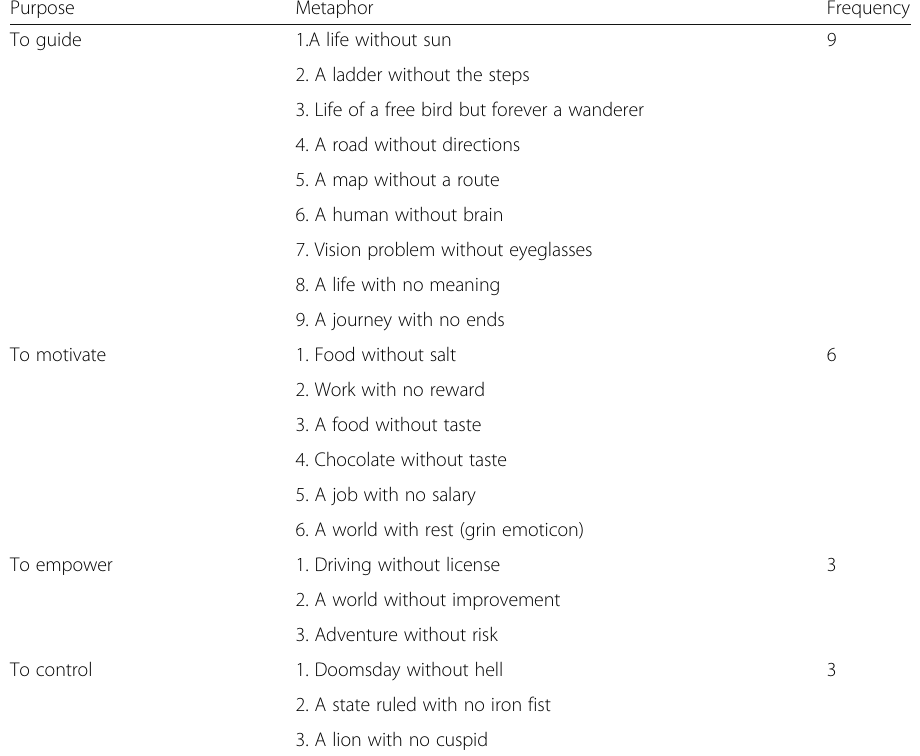
Table 1 Metaphors and purposes of assessment Purpose Metaphor Frequency To